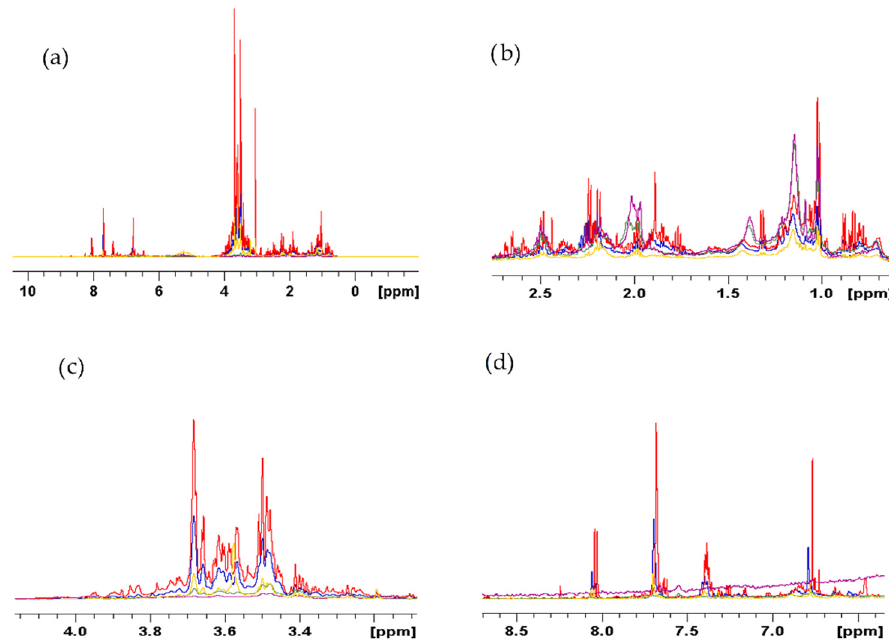
Figure 2. ( a ) Stack plot comparison of the 1D 1 H spectra of different solvent extracts of E. foeminea recorded using 600 MHz solution NMR and dissolved in D 2 O; ( b ) extended region of CH 3 and CH 2 mainly CH 3 of amino acids ( δ 3 ‒ 0); ( c ) polysaccharides extended region ( δ 4.5 ‒ 3); and ( d ) aromatic region. Yellow, ethanolic extract; purple, ethyl acetate extract; green, acetone extract; red, methanolic extract; blue, dichloromethane/methanol extract.